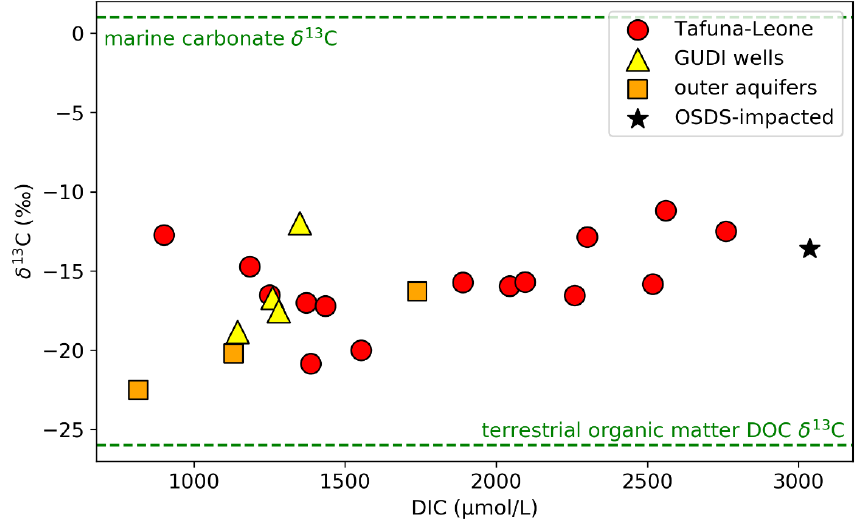
Figure 8. Scatterplot showing the distribution of seawater-unmixed values of DIC and δ 13 C DIC . The OSDS-impacted endmember is obtained from Richardson et al. [50]. This endmember represents mean DIC and δ 13 C values measured from OSDS impacted coastal springs in Hawai’i. Typical